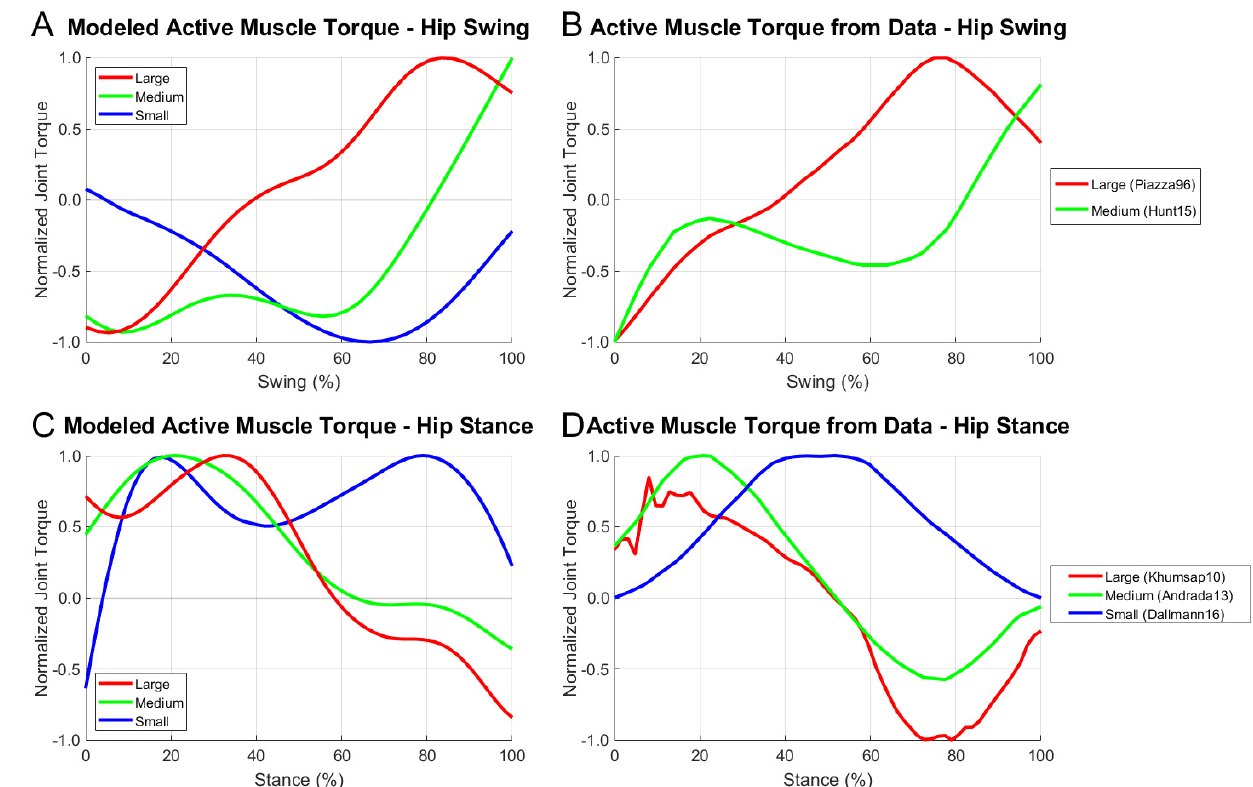
Figure 8. Active joint torque at different size-scales for the modeled rat hip during stance and swing compared with data for animals of different size-scales. Torque values are normalized with respect to the maximal torque during each phase. Modeled animal sizes and coloring represent the general size-scaling of the data subjects above. Animals of each size category were selected based on availability in the literature.